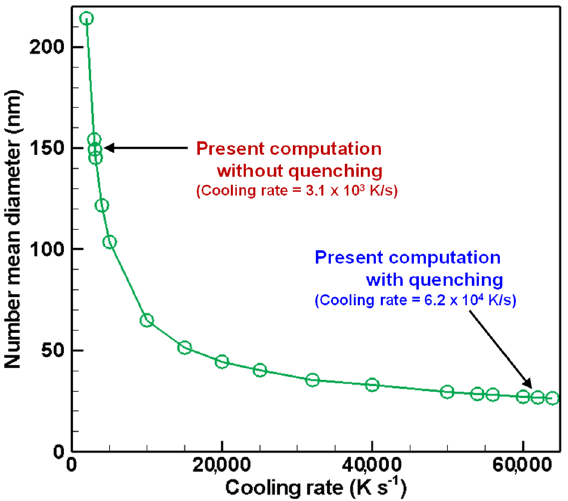
Figure 18. Cooling rate dependence on number mean diameter of silicon nanoparticles.